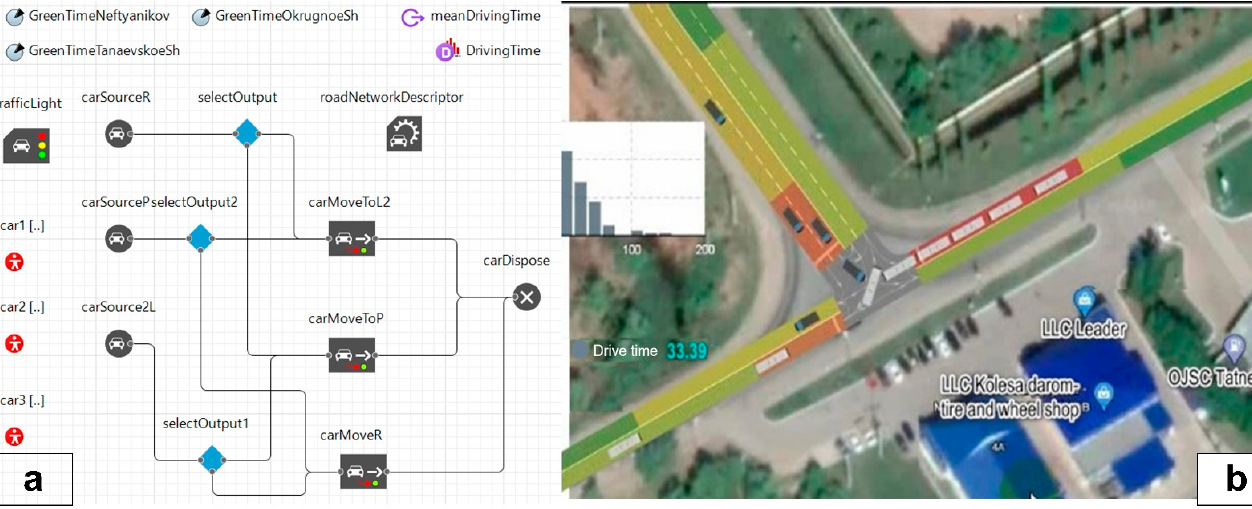
Figure 7. ( a ) SM of the road network section after the changes. ( b ) Optimization experiment results (sign “downward arrow”means that functionality is minimized). 5.5. Implementation of Continuous Control The advantage of the SM is also that it can be used for a preliminary assessment of the proposed solution effectiveness. With the optimal parameters obtained as a result of the SM run for a three-phase control cycle, we found that traffic jams at this intersection do not practically form (Figure 7a), thus the number of conflict situations, and, accord- ingly, the accident likelihood are reduced. This will probably increase the level of traffic safety in this city. 6. Conclusions